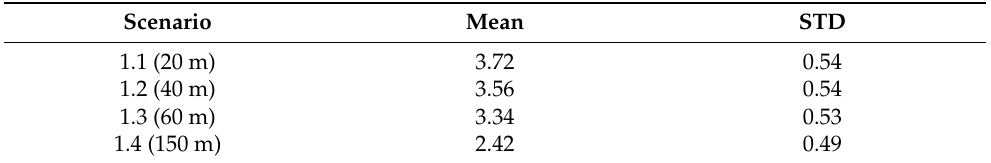
Figure 12. Measured distances against the maximum allowed spread for each sensor and scenario configuration. Table 3. Number of Reference Points that detect a vessel